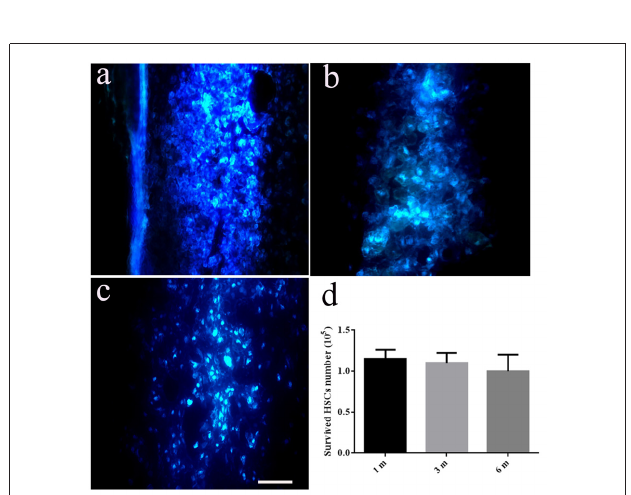
FIGURE 3 | Transplanted HSCs survived and migrated in the host spinal cord. There are no positive HSCs with blue staining marked by Hoechst 33342 in the spinal cord without HSC transplantation. While, HSCs with blue staining in nucleus could be seen at the first month (A) , third month (B) and sixth month post transected spinal cord injury (SCT) (C) , indicating the survival and migration of the transplanted HSCs in the host spinal cord. (D) Bar chart for quantitative analysis of the survived HSCs in vivo using Image-Pro Plus 6.0 software. Data are presented as the mean ± SD ( n = 3, one-way ANOVA). Bar = 50 µ m. m,